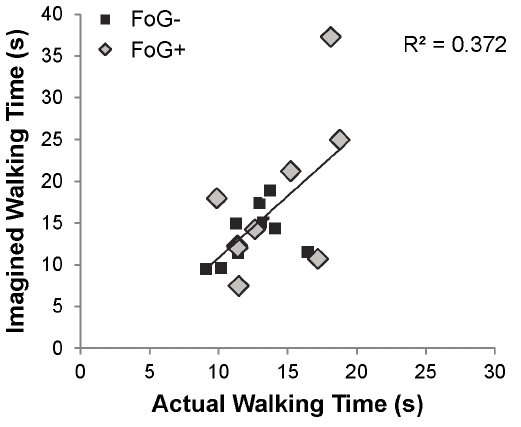
Figure 4. Correlation between actual and imagined walking times for freezers and non-freezers. Correlation statistics represent all